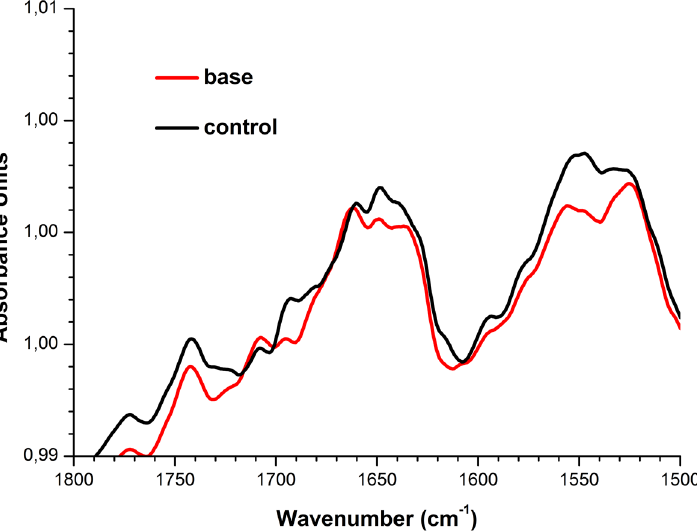
Figure 4. Results of attenuated total reflection Fourier-transform infrared spectroscopy (ATR-FTIR) experiments. Typical ATR-FTIR spectra obtained for 10 −4 M HRP solutions incubated in the center of the pyramid’s base (red), or far away from the pyramid (control solution;